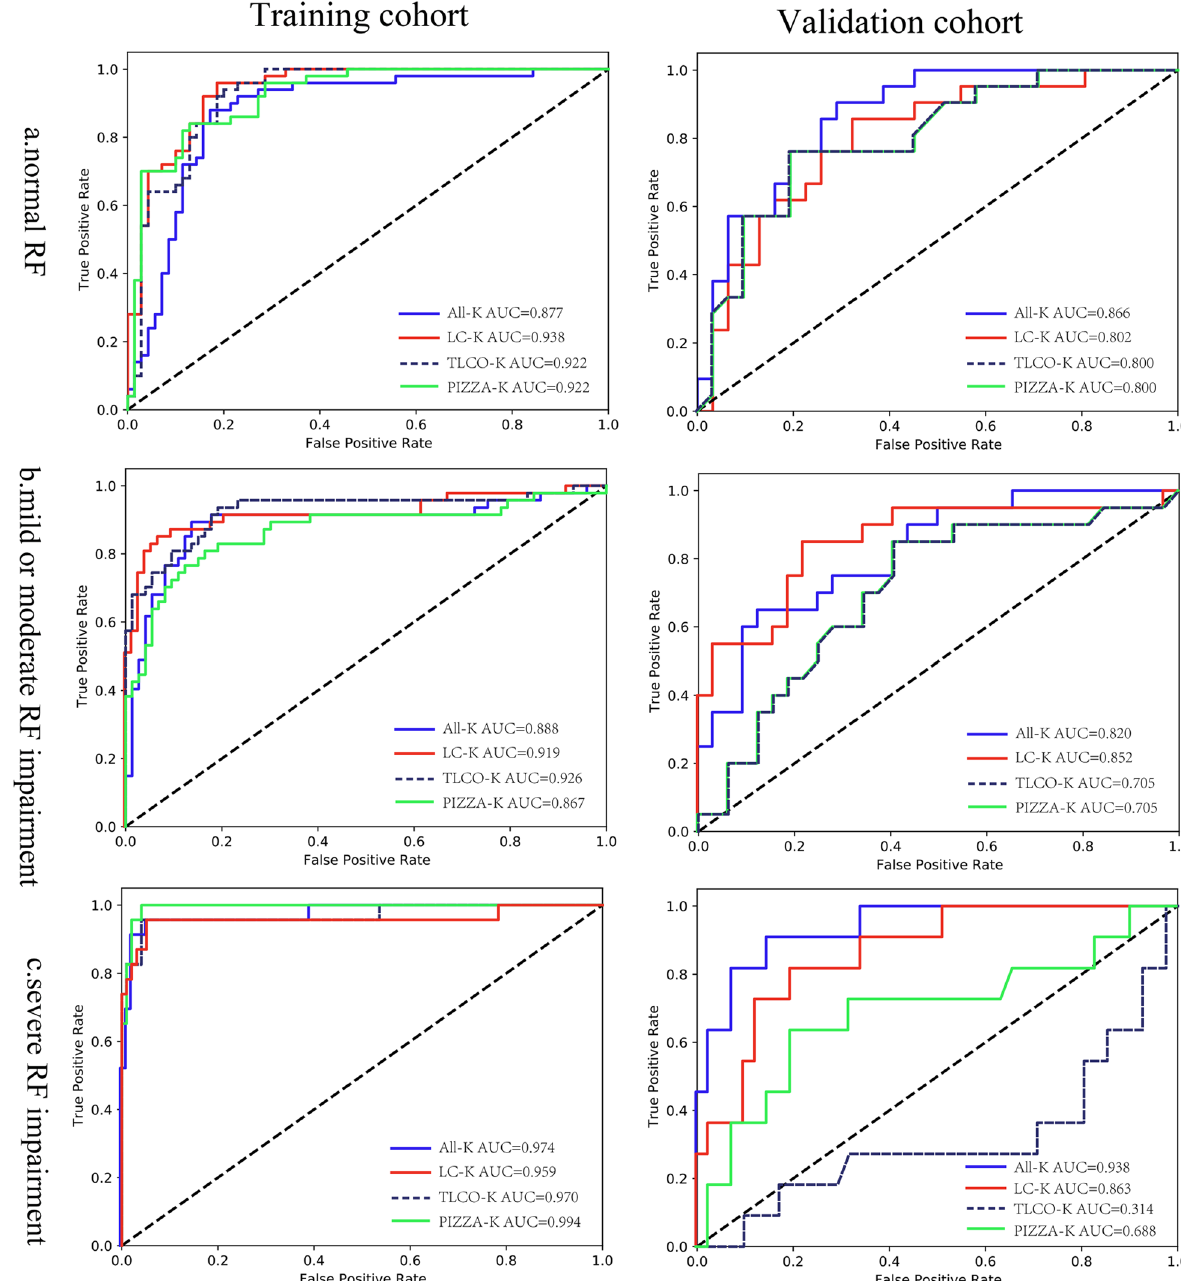
Fig. 2 The ROC curves of four models on normal renal function, mild or moderate and severe renal function impairment in the training and validation cohorts. Note: ROC, receiver operating characteristic; RF, renal